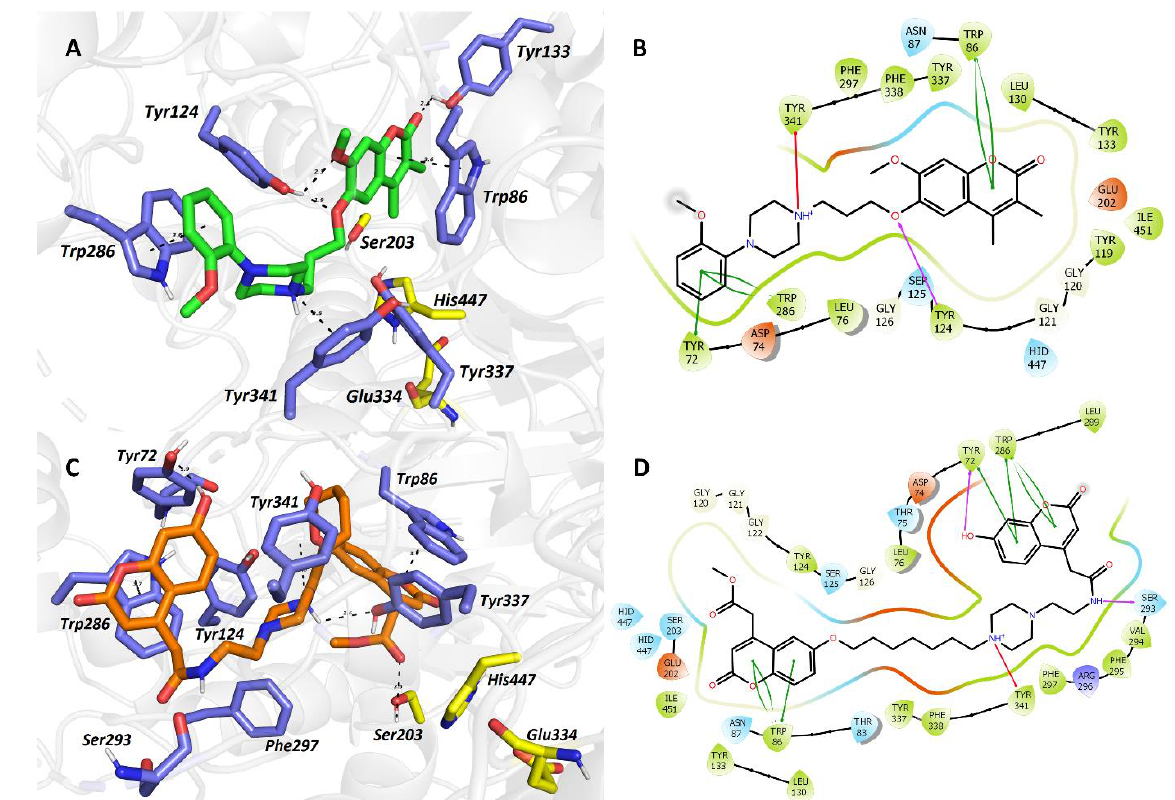
Figure 4. The top-scored docking poses of ligands KA-672 ( A , B ) and 12d ( C , D ) in the h AChE active site (PDB ID: 4EY7). The ligands are displayed in green (KA-672, ( A )) and orange ( 12d , ( C )); important amino acid residues responsible for ligand anchoring are shown in dark blue. Catalytic triad residues are displayed in yellow. Important interactions are rendered by black dashed lines; distances are measured in angstroms (Å). The rest of the receptor is displayed in light-grey cartoon conformation ( A , C ). Figures ( A , C ) were created with the PyMOL Molecular Graphics System, Version 2.4.1, Schrödinger, LLC. Two-dimensional figures ( B , D ) were generated with Maestro 12.3 (Schrödinger Release, Schrödinger, LLC, New York, NY, USA,